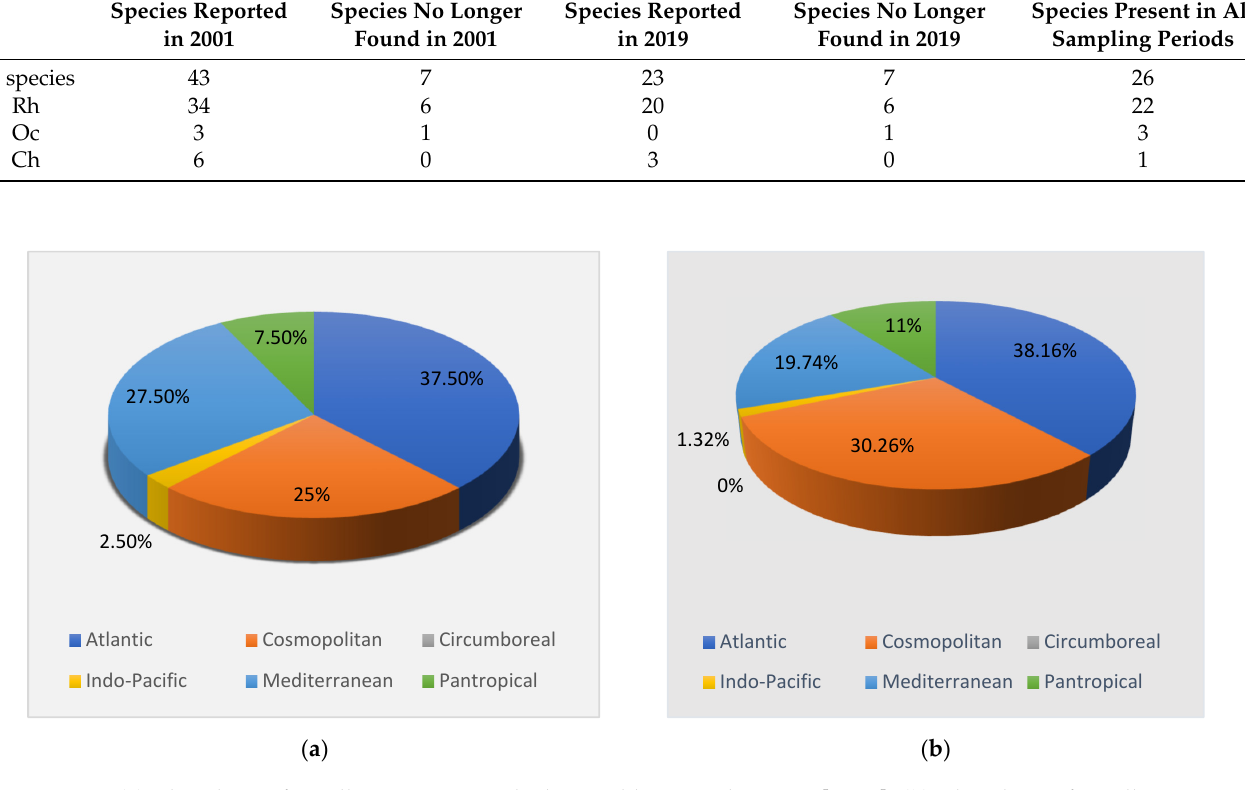
Figure 7. Values of Simpson’s Dominance index (D), Simpson’s index (1-D), Shannon’s index (H) Evenness index (J’) and R/P index in the coralligenous macroalgal assemblages of the 1970s, 2001, and 2019.